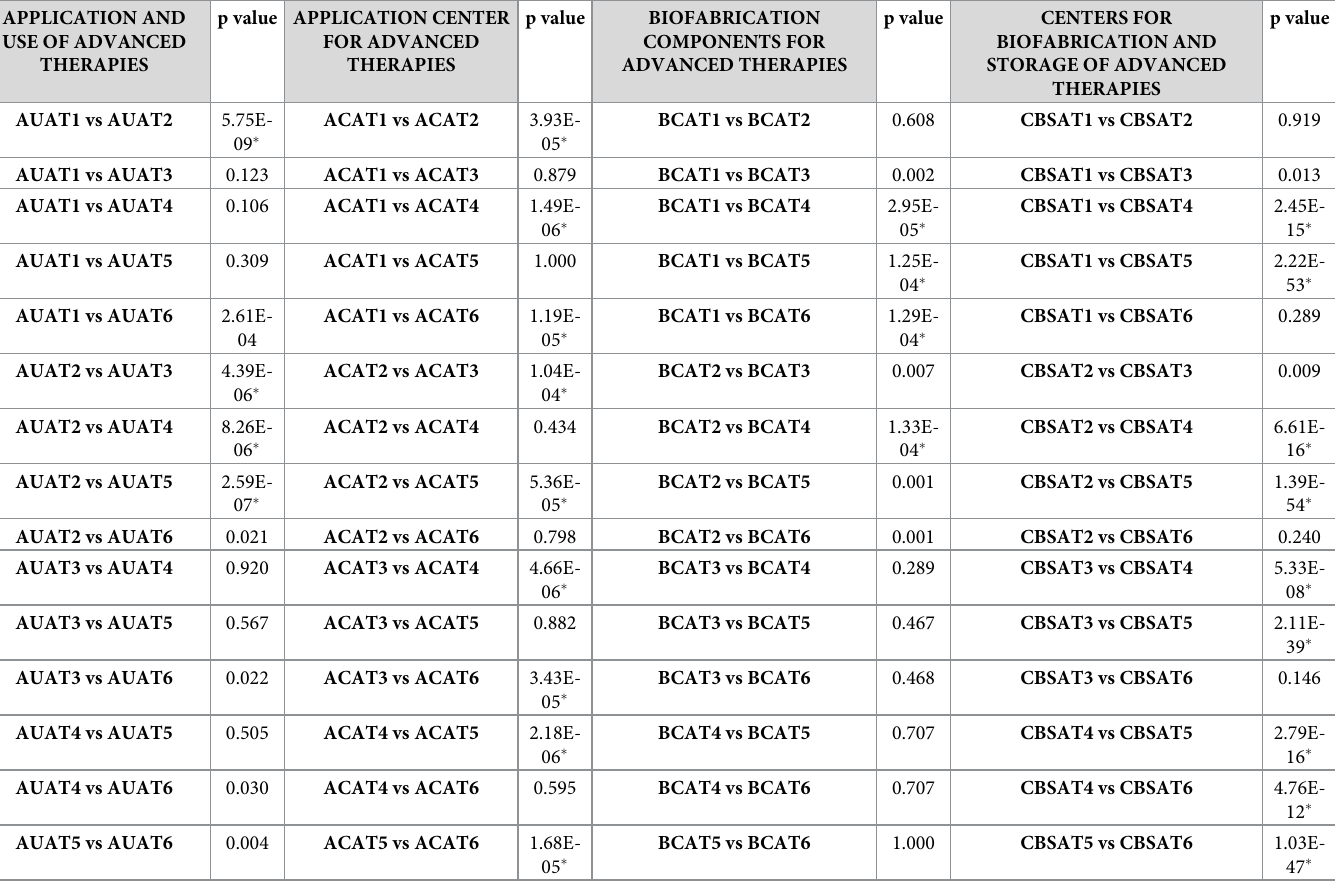
Table 6. Statistical p values for pairwise comparisons of two specific items included in each topic of the procedural component.